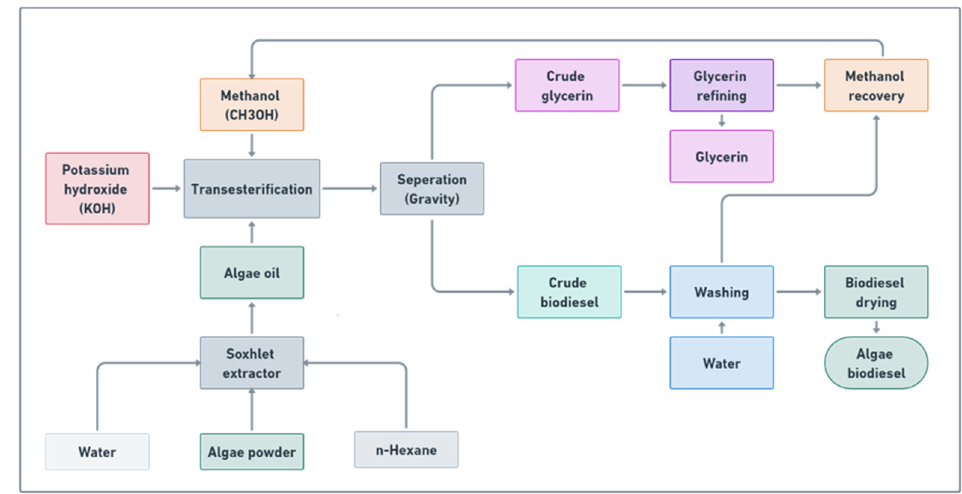
Figure 1. Schematic diagram of biodiesel production from algae. The physiochemical properties of algae biodiesel were tested according to ASTM standards and listed in Table 1, along with diesel and ethanol